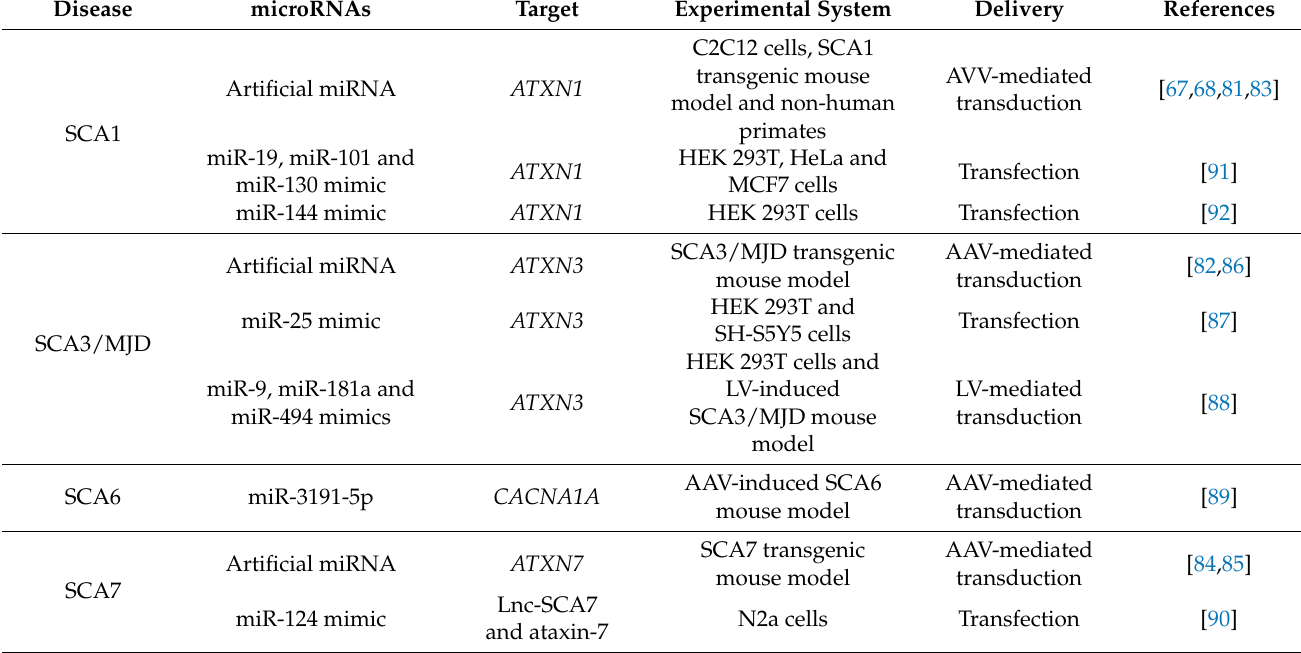
Table 5. Selected microRNAs studies in polyglutamine spinocerebellar ataxias.